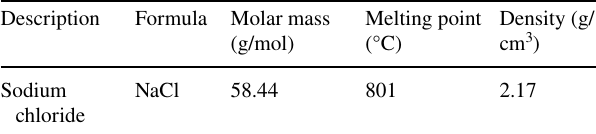
Table 1 Properties of sodium chloride